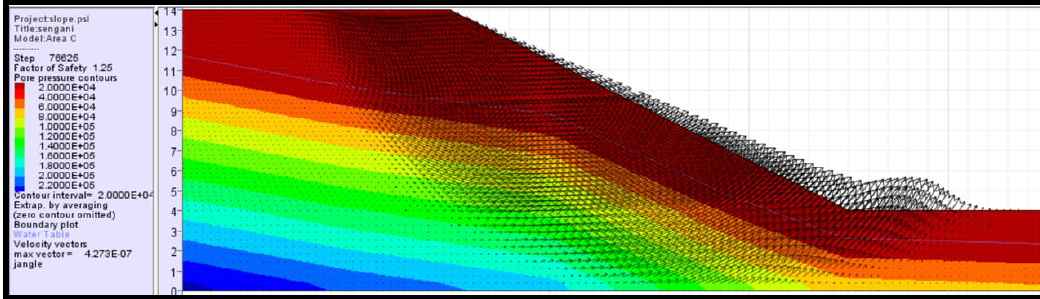
Figure 38. Simulated water pore pressure of the soil slope using FLACSlope in rainy conditions with a water table with 2500 m 3 volume of water.